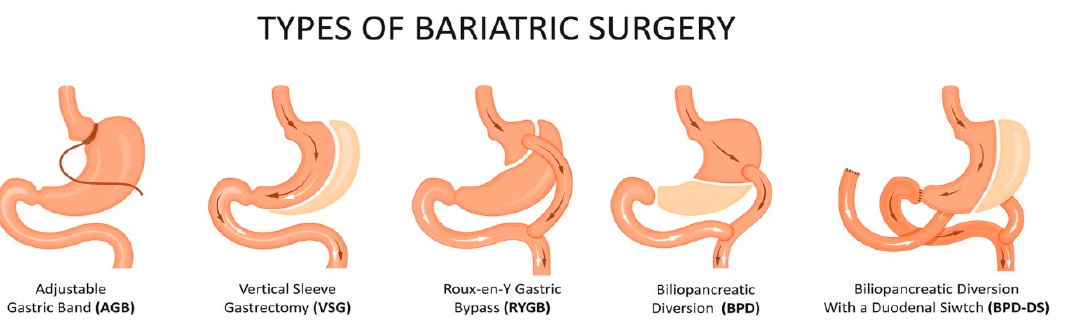
Figure 1. Types of commonly performed bariatric surgery procedures. (Source: https://www.istockphoto.com/ , accessed on 14 August 2021)